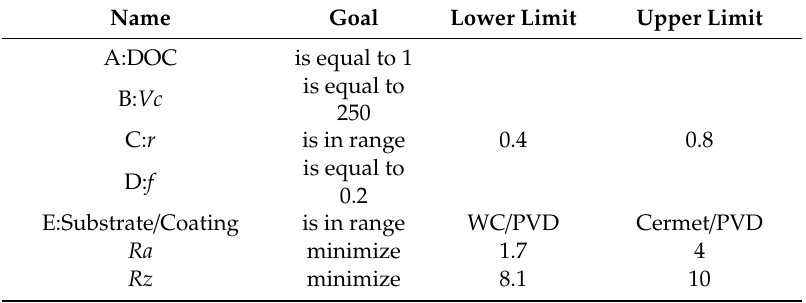
Table 12. Goals and parameter ranges for optimization of Ra and Rz responses.